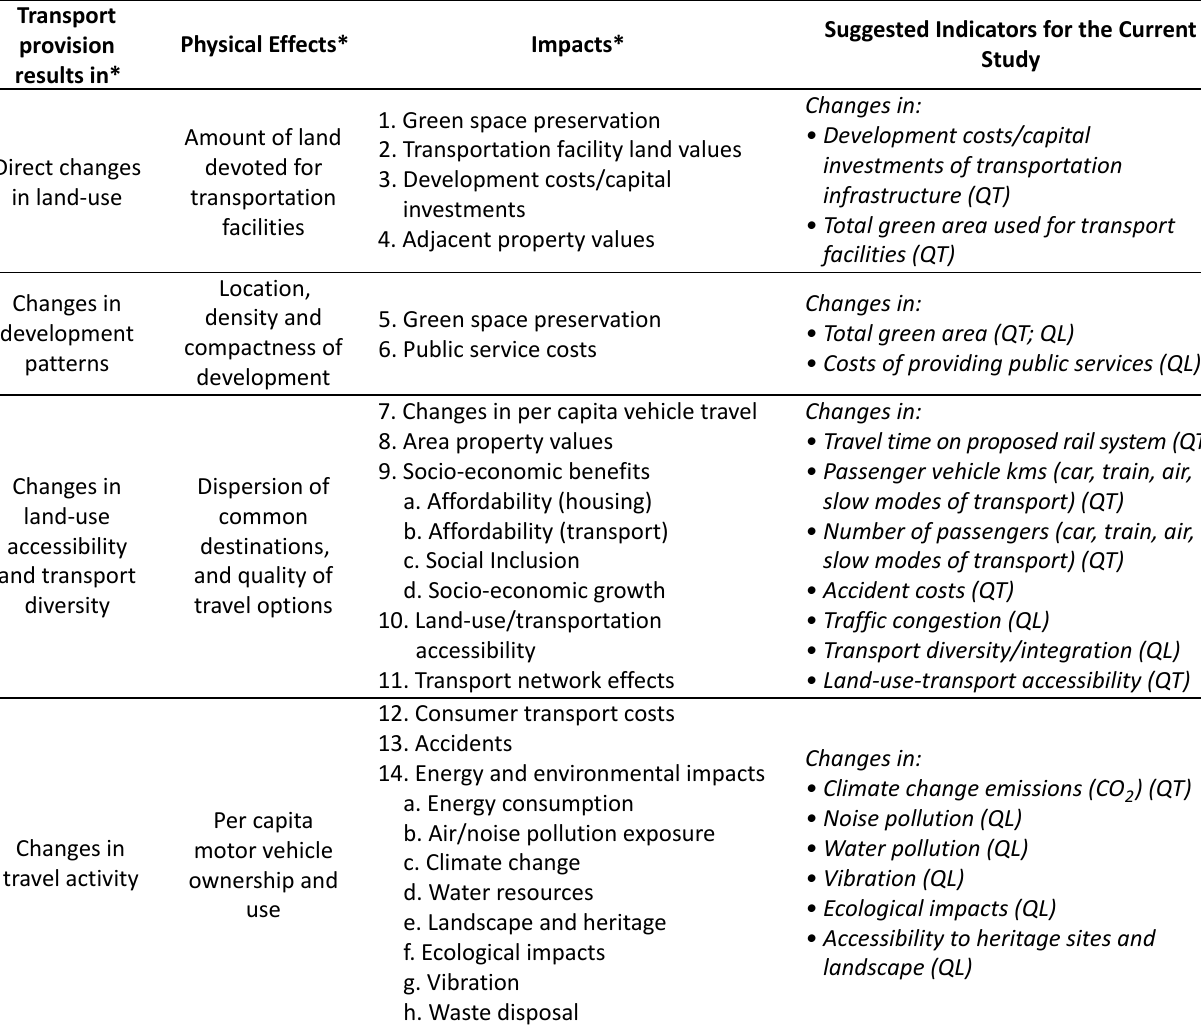
Table 5. Impacts of transportation provision on land-use and suggested indicators for the current study. QT: quantitative assessment, QL: qualitative assessment. Adapted from Litman